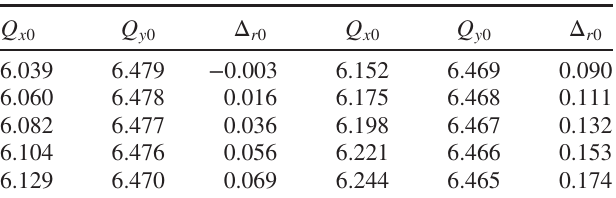
TABLE I. Measured transverse tunes for the working points used in the measurement campaign. The average value resulting from three independent measurements is shown. The vertical tune is slightly shifted with respect to the constant programmed value. Δ r 0 corresponds to the distance of the resonance as defined in Eq. (1).